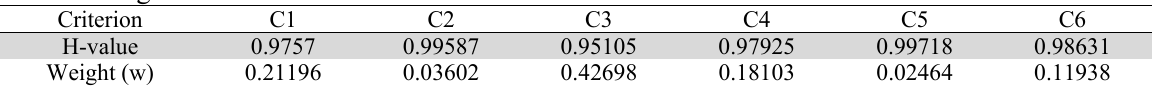
Criteria Weight Criterion